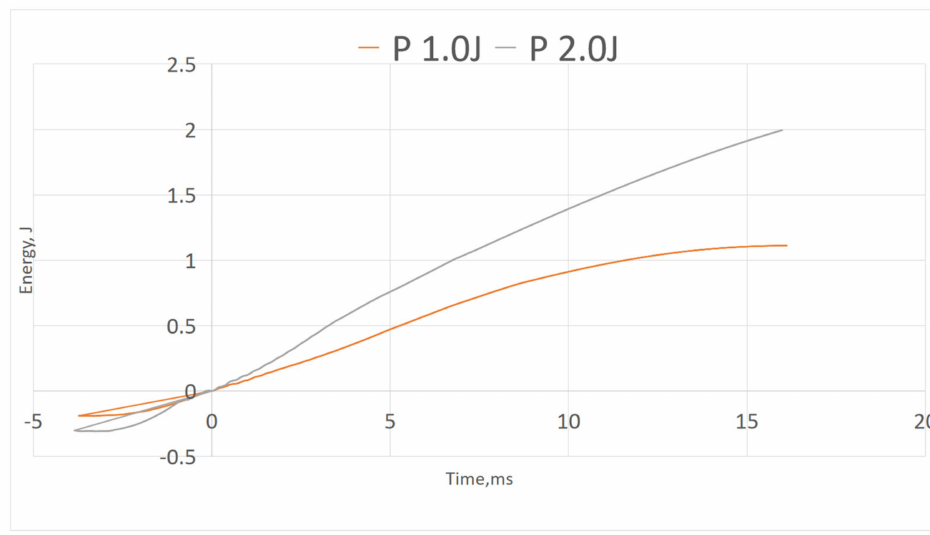
Figure 12. Energy-time of P.